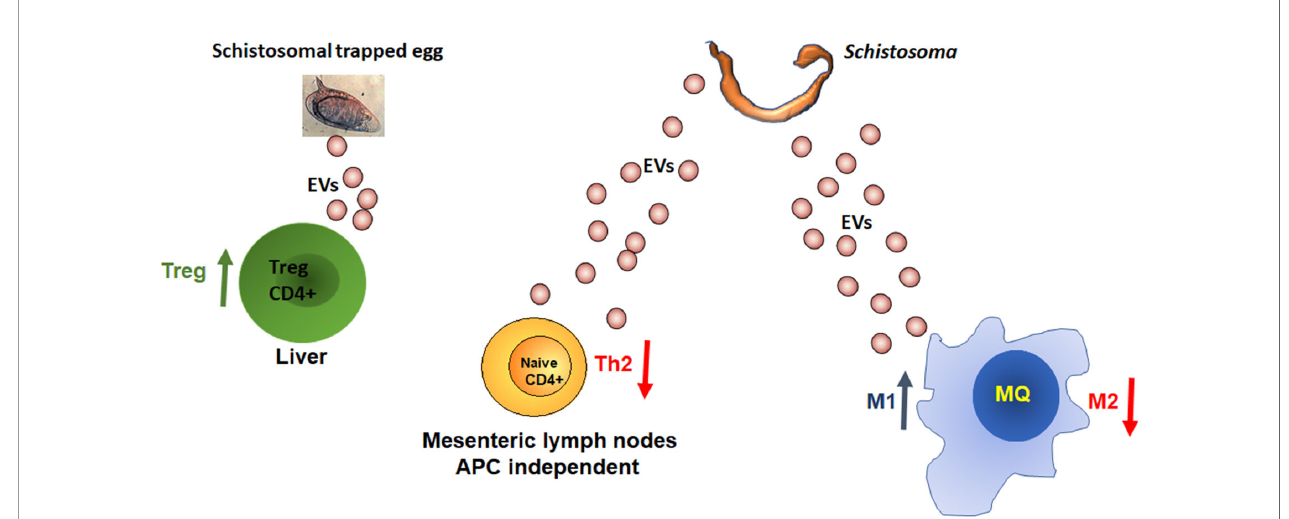
FIGURE 2 | MiRNAs from schistosomal EVs manipulate the host immune response. More details in the